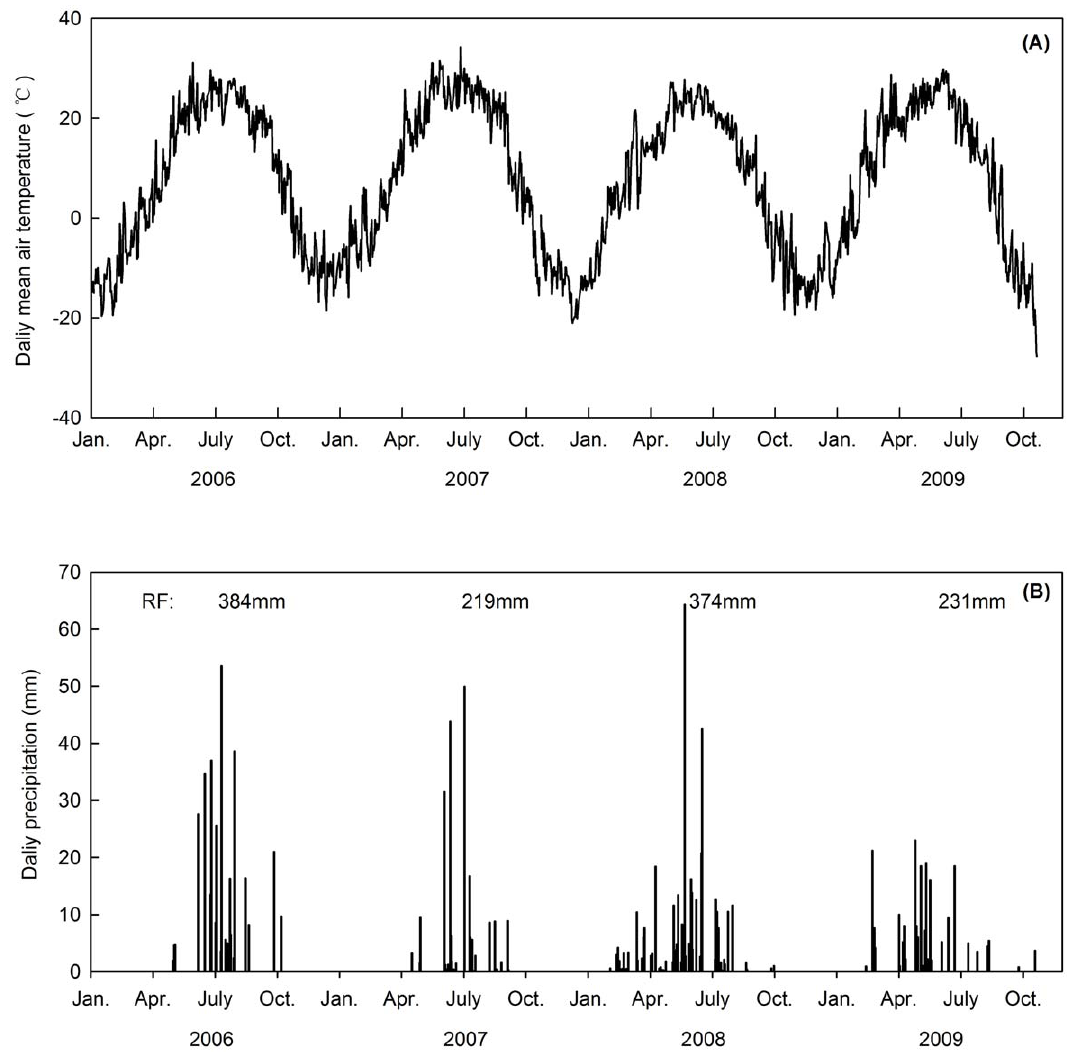
Figure 1. Daily mean air temperature, annual rainfall (RF), and daily precipitation in 2006, 2007, 2008 and 2009. Data for 2006 were obtained from a weather station located in the Chang Ling Horse Breeding Farm in Jilin Province, 3 km in distance from the study site. Data in 2007, 2008 and 2009 were obtained from an eddy tower roughly 200 m distant from the experimental plots.